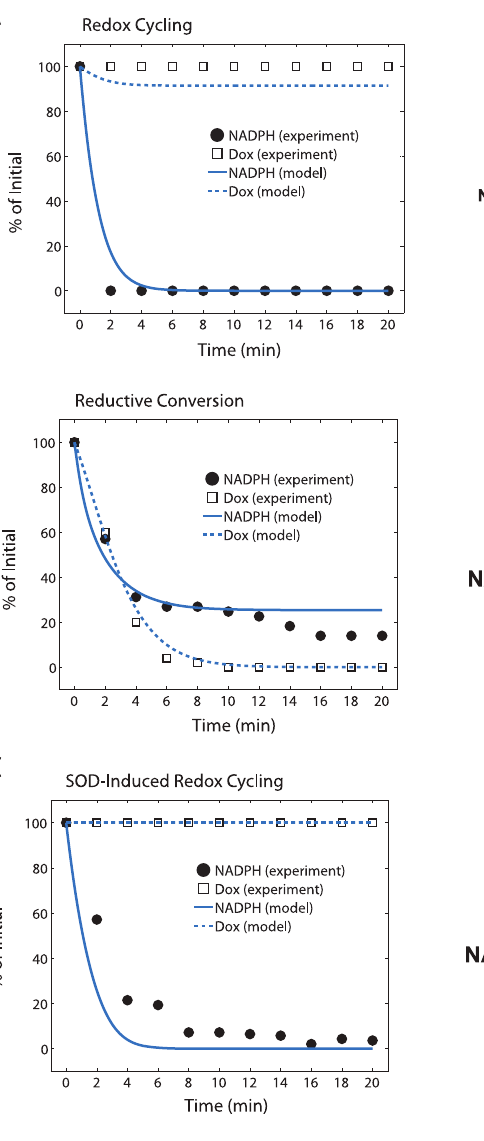
Figure 1. Three proposed mechanisms for invitro doxorubicin bioactivation. (A–C) Experimental data [3] and model fitted results for different doxorubicin bioactivation pathways accompanied by a schematic representation of the hypothesized network underlying each pathway. Large fonts denote experimental conditions in which the [NADPH] was increased from 100 m M to 500 m M.